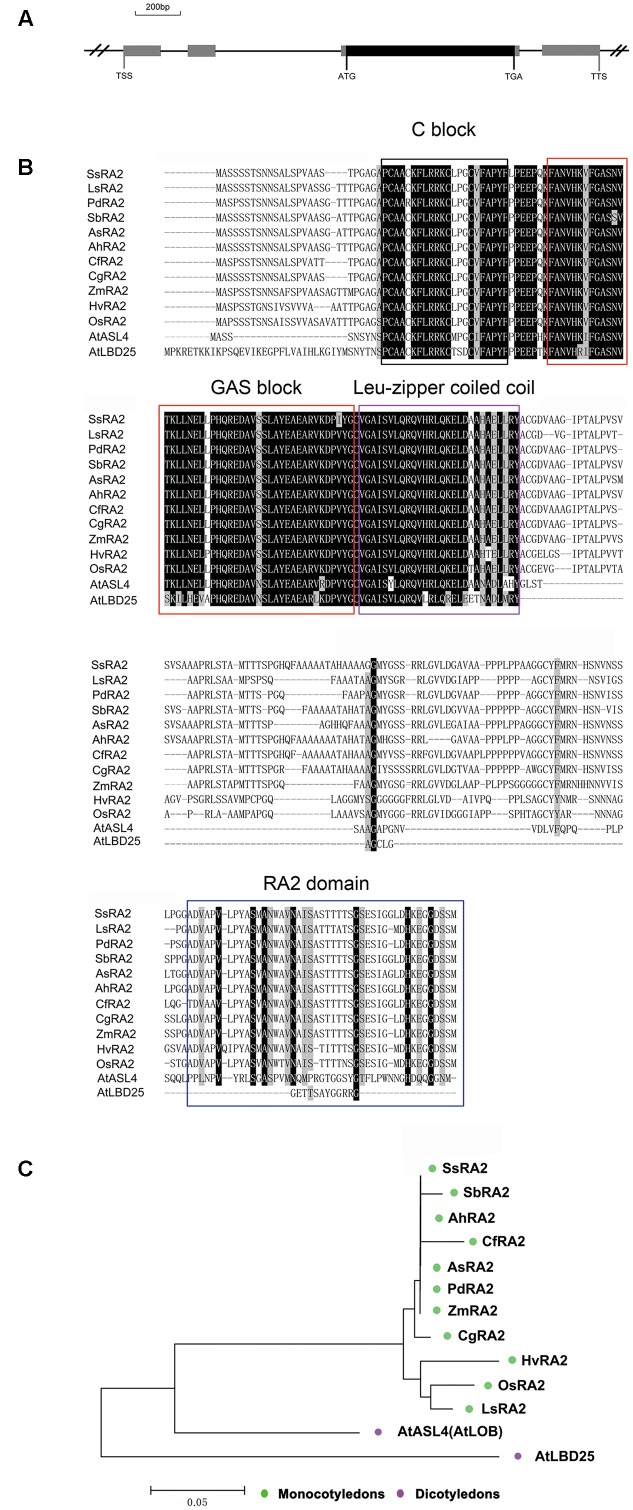
Analysis of OsRA2 and comparison with other grass RA2 proteins and Arabidopsis LBD proteins. (A) Schematic of OsRA2. Black box represents the protein-coding region and gray ones represent exons. (B) Alignment of the deduced full-length amino acid sequences of SsRA2, SbRA2, AhRA2, CfRA2, AsRA2, PdRA2, ZmRA2, CgRA2, HvRA2, OsRA2, LsRA2, AtASL4 and AtLBD25. The respective species are listed in the Materials and methods. Protein domains are framed in black for C-block, red for GAS-block, purple for Leu-zipper coiled coil and blue for the RA2 domain. (C) Phylogenetic tree of grass RA2 proteins and Arabidopsis LBD proteins.